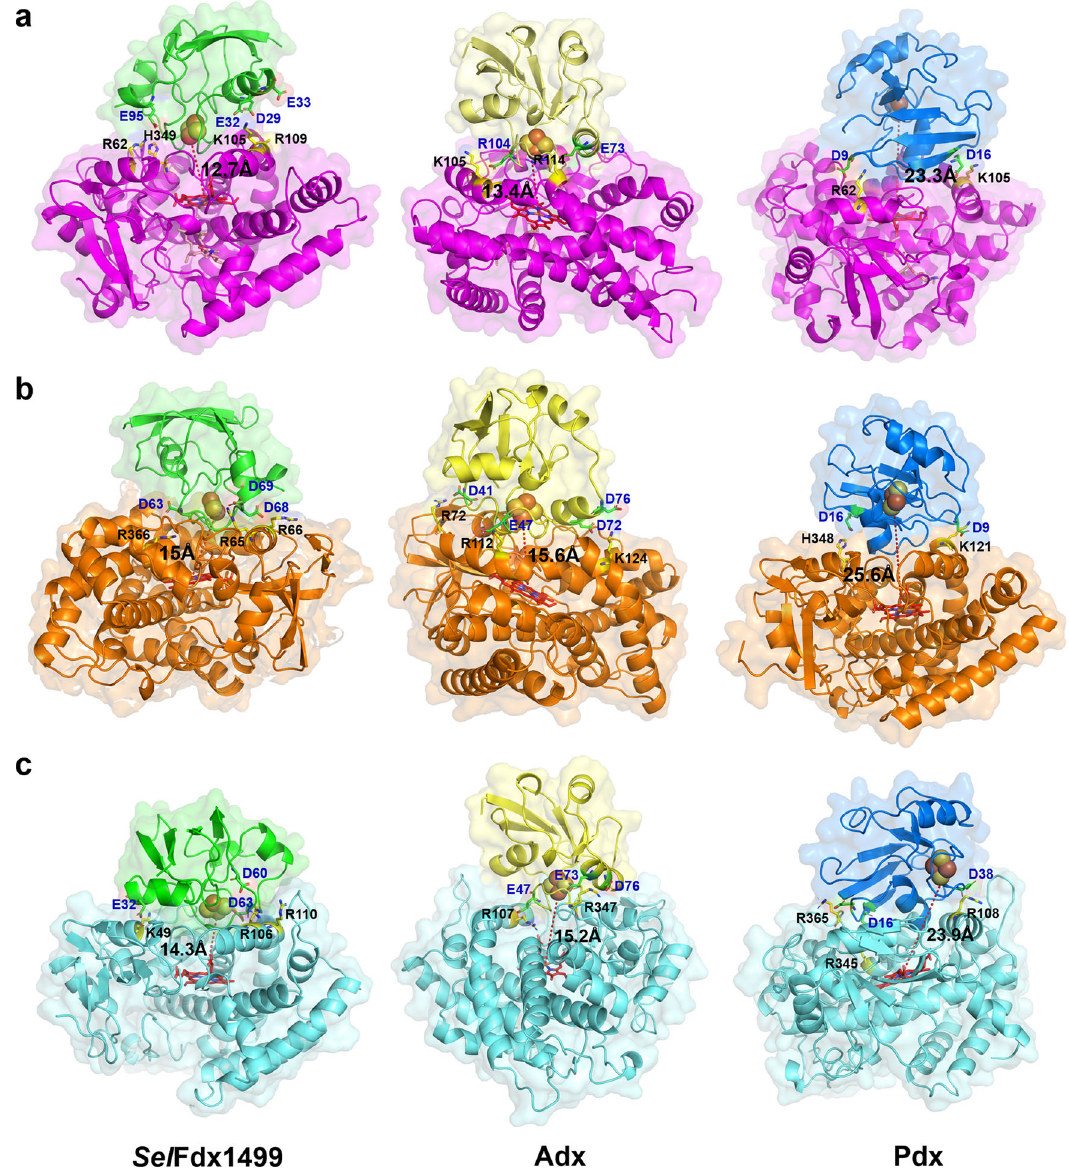
Fig. 5 Fdx-P450 docking models. Docking models of three Fdxs in complex with PikC ( a ), P450sca-2 ( b ), and CYP-sb21 ( c ). The structures of P450-Fdx complexes are shown as cartoon with different colors. The key interacting residues on P450-Fdx interfaces are shown as sticks in yellow and green, respectively. Heme and substrates are shown as sticks in red and wheat, respectively. The Fe 2 S 2 cluster are shown as spheres. The distances (Å) between the iron – sulfur cluster and heme-iron are indicated by dashed red